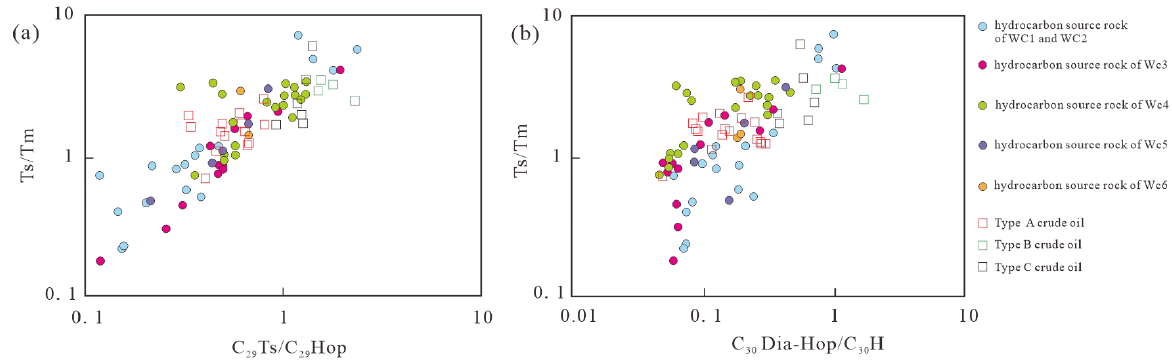
Figure 8. Comparison of parameters of biomarkers of crude oil and source rocks in the southern Lufeng sag: ( a ) relationship between C 29 Ts/C 29 Hop and Ts/Tm; ( b ) relationship between C 30 Dia-Hop/C 30 H and Ts/Tm.